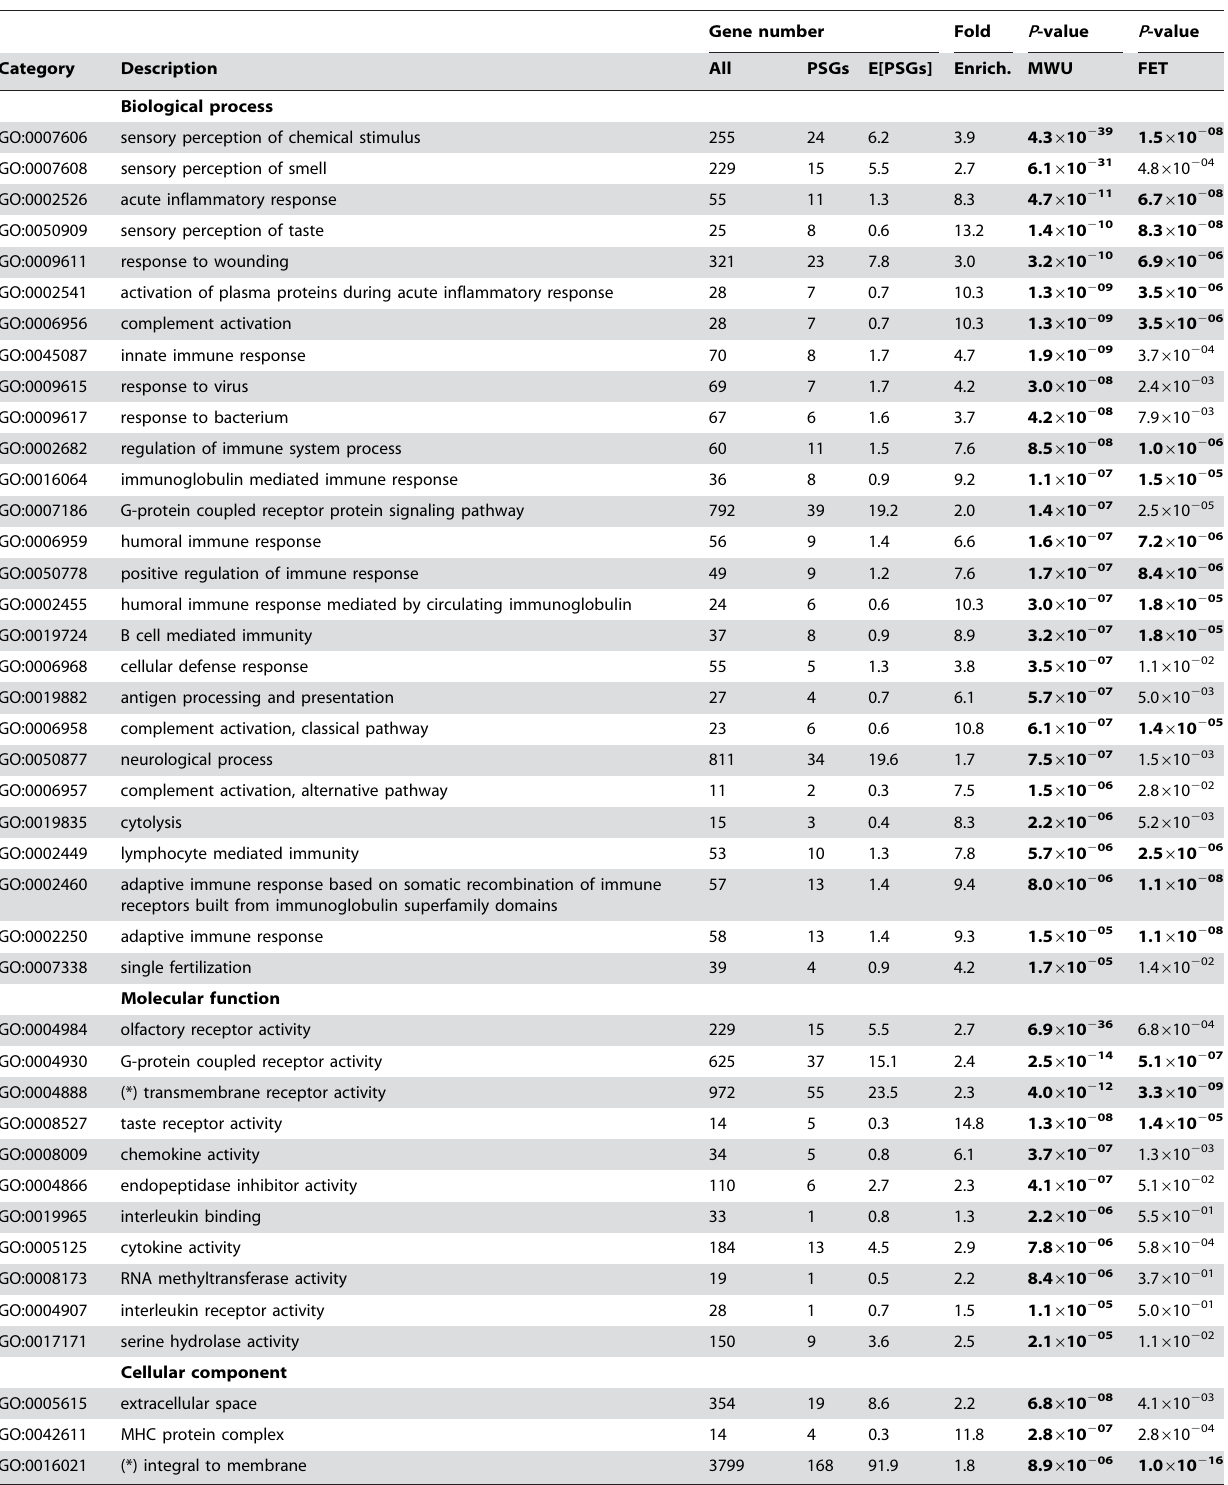
Table 2. Selected GO categories over-represented among genes predicted to be under positive selection.